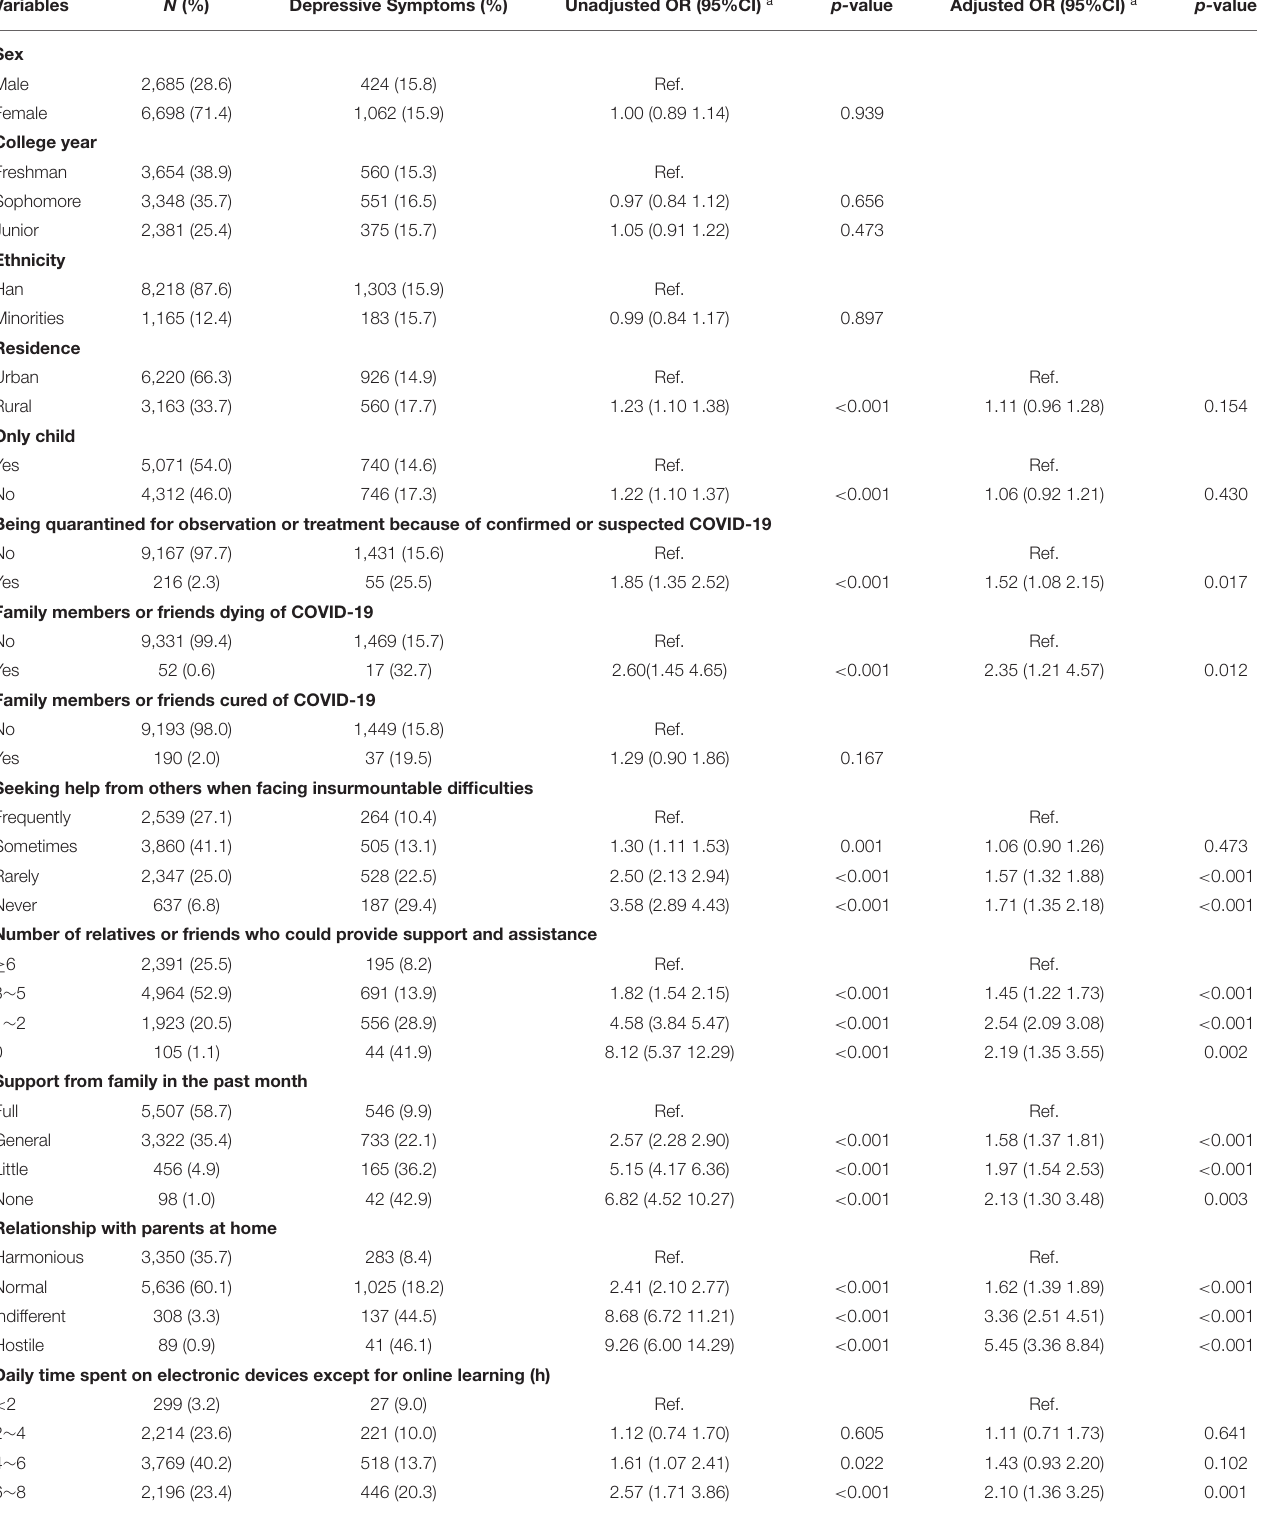
TABLE 1 | Binary logistic regression analyses on the factors associated with depressive symptoms among 9383 college students in Wuhan, China during the normalization stage of COVID-19 prevention and control.